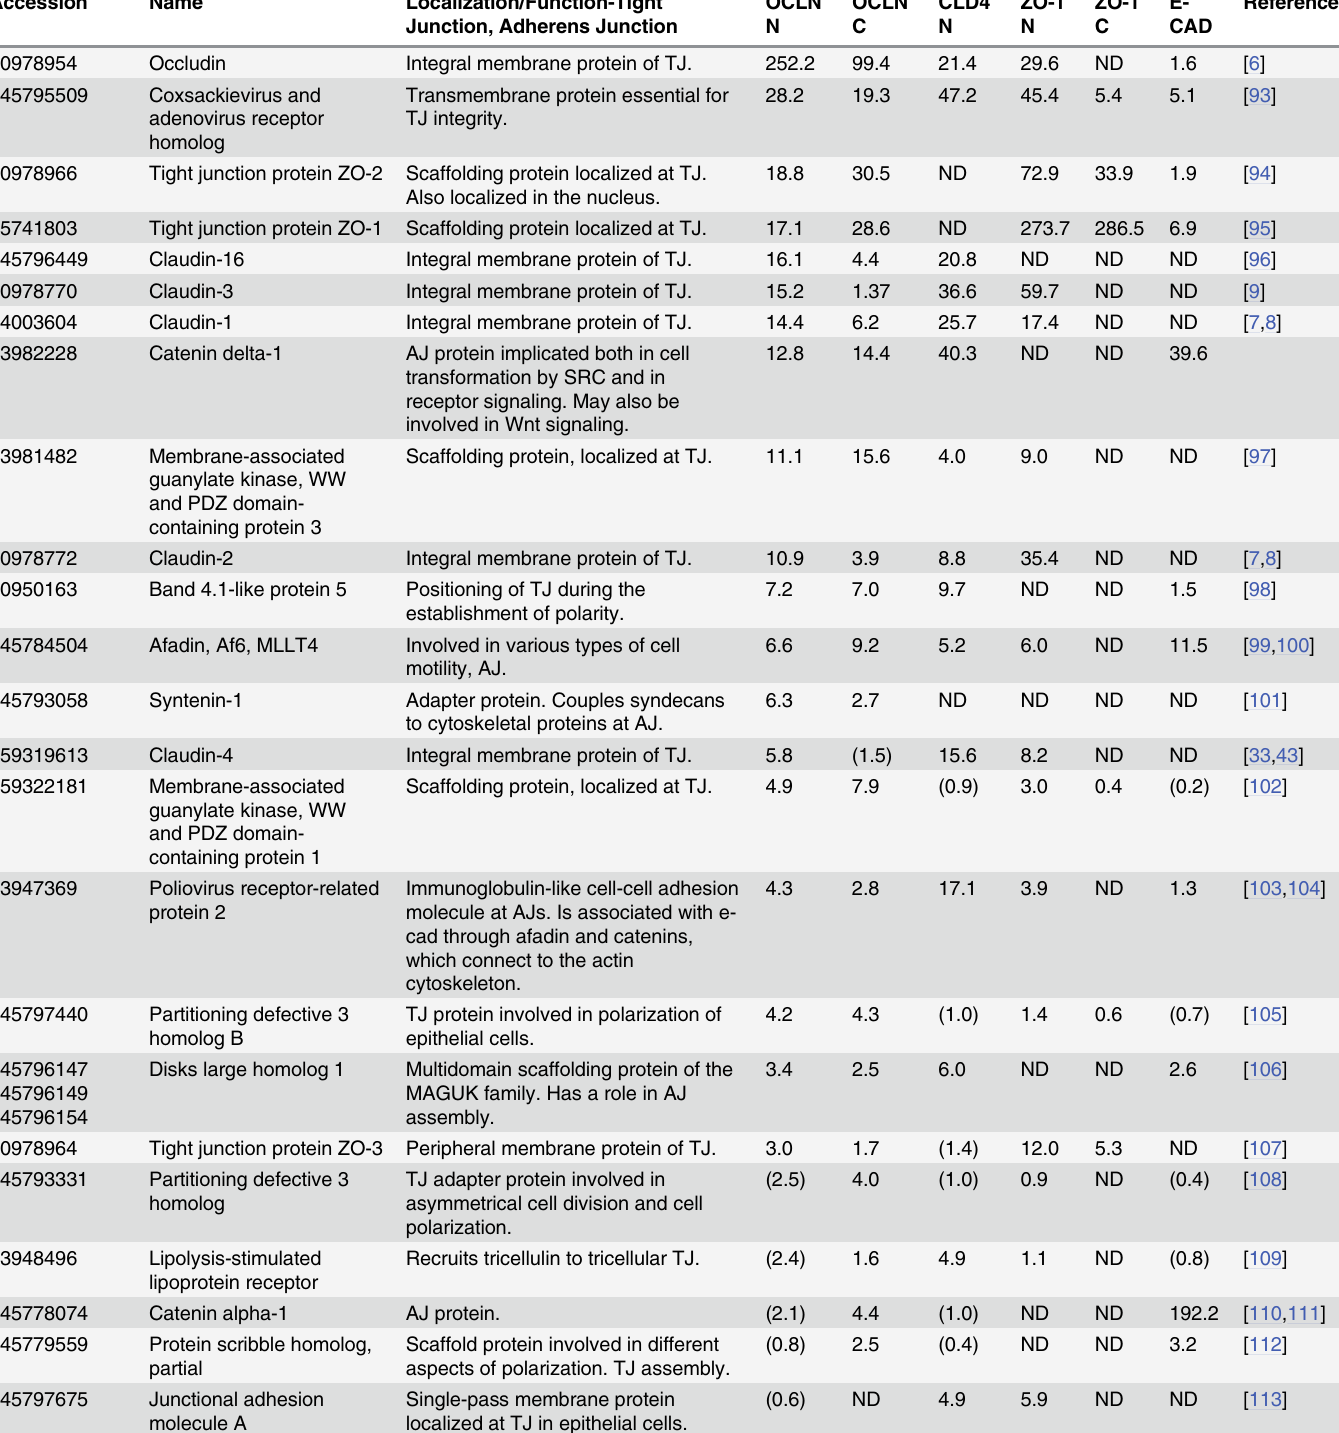
Table 1. Enriched tight junction (TJ) and adherens junction (AJ) proteins tagged by biotin ligase fused to occludin and claudin-4.